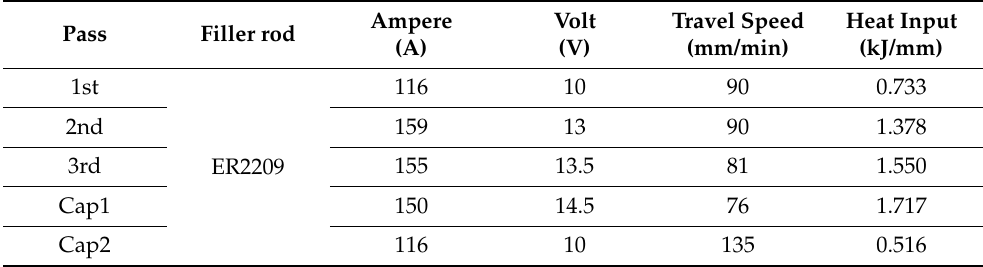
Table 3. GTAW welding